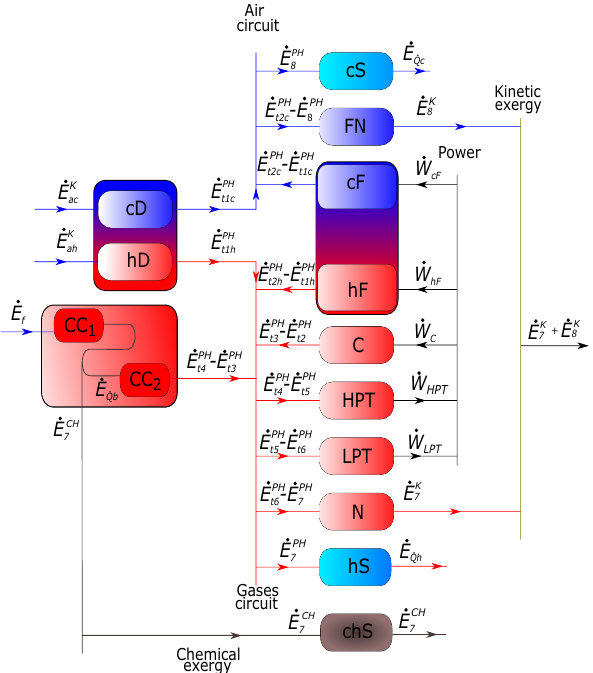
Figure 2. Productive structure of a turbofan engine. hS, hot